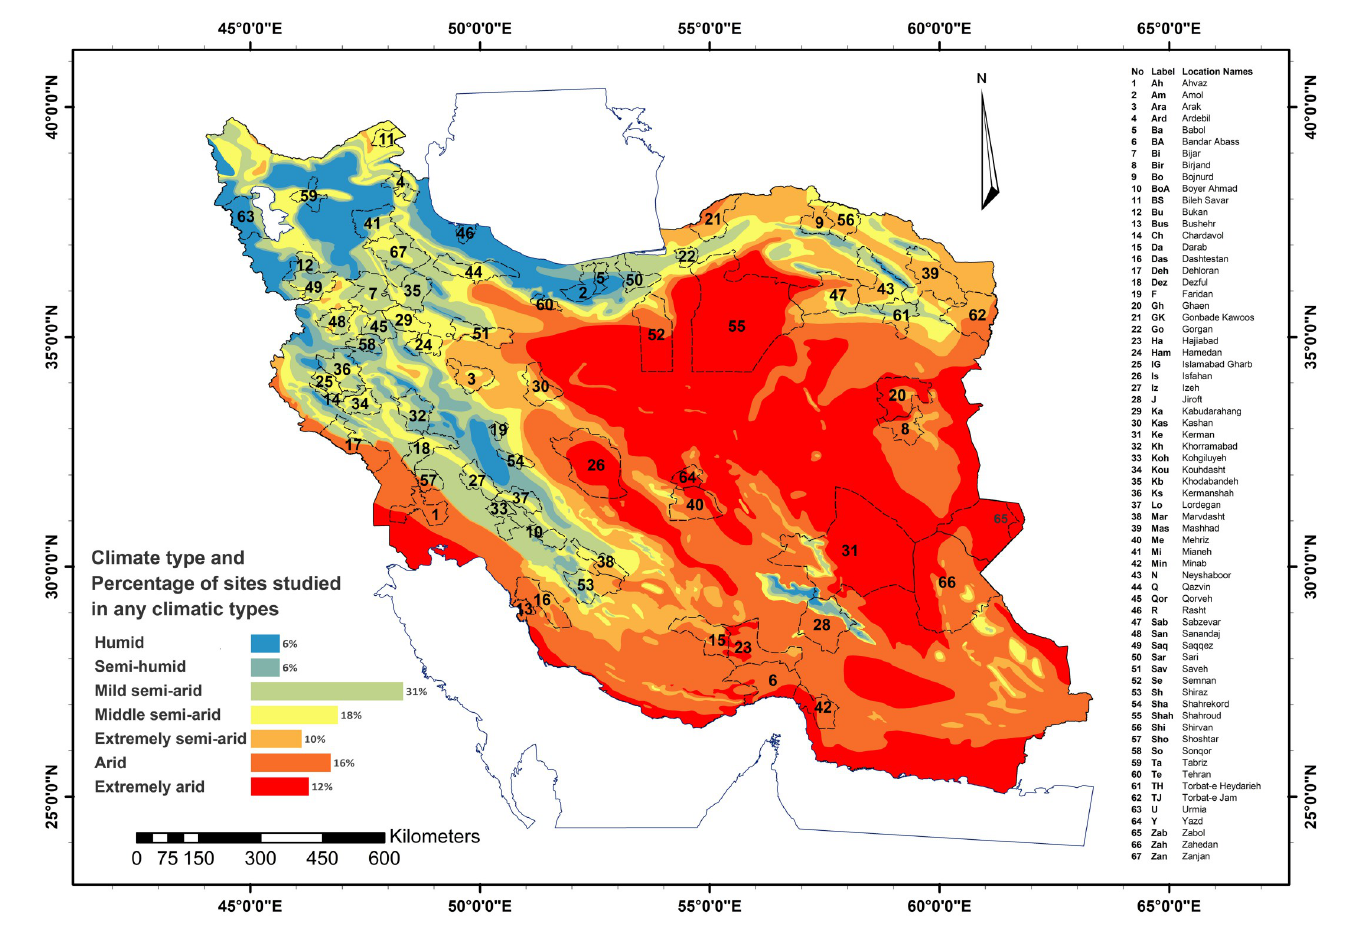
Fig 1. The geographical locations of the investigated sites (Dashed lines) based on the highest cropland area in Iran. The percentage of sites studied in any climatic types are shown in the legend of the figure. Dashed lines indicate Urban boundaries. Ko¨ppen-Geiger climate classification map obtained from Forest, Range and Watershed Managment organization (http://www.frw.ir). This maps was realised with ArcGIS 10.8 (http://www.esri.com/arcgis) using the georeferenced shapefiles obtained from the National Geographical Organization of Iran and National Cartographic Center (https://www.ncc.gov.ir/en/) at a scale of 1:11,000,000.